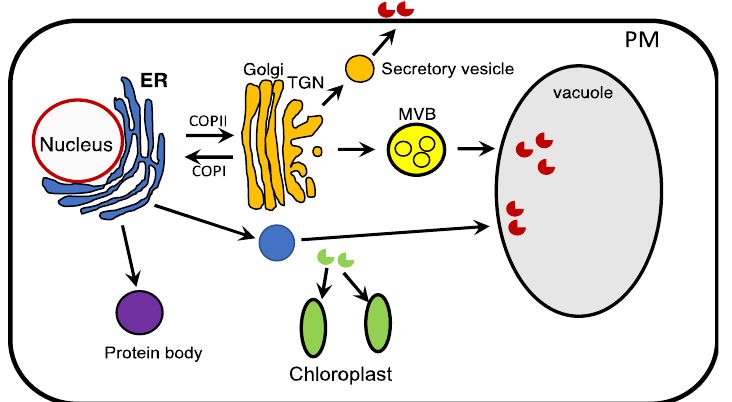
Figure 4. Targeting of nuclear-encoded recombinant proteins to different subcellular compartments for enhancing their production. ER-synthesized recombinant proteins can be targeted to the apoplast, vacuole, or protein bodies. Recombinant proteins synthesized in the cytosol can be targeted to chloroplasts with a N-terminal transit peptide.